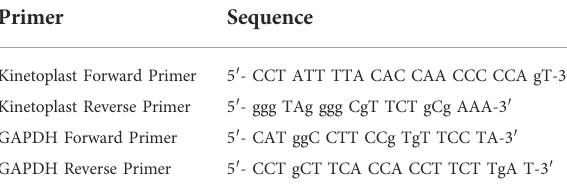
TABLE 2 Sequence of primers used in the q-RT-PCR for detection of kinetoplast and the housekeeping gene GAPDH. Primer